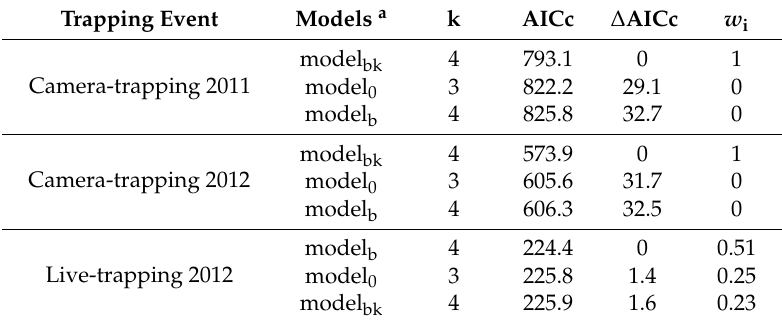
Table 2. Model selection summary of camera- and live-trap SCR data over two winters in northern New Hampshire, USA. Models were evaluated using AICc, ranked using ∆ AICc and model weight ( w i ).